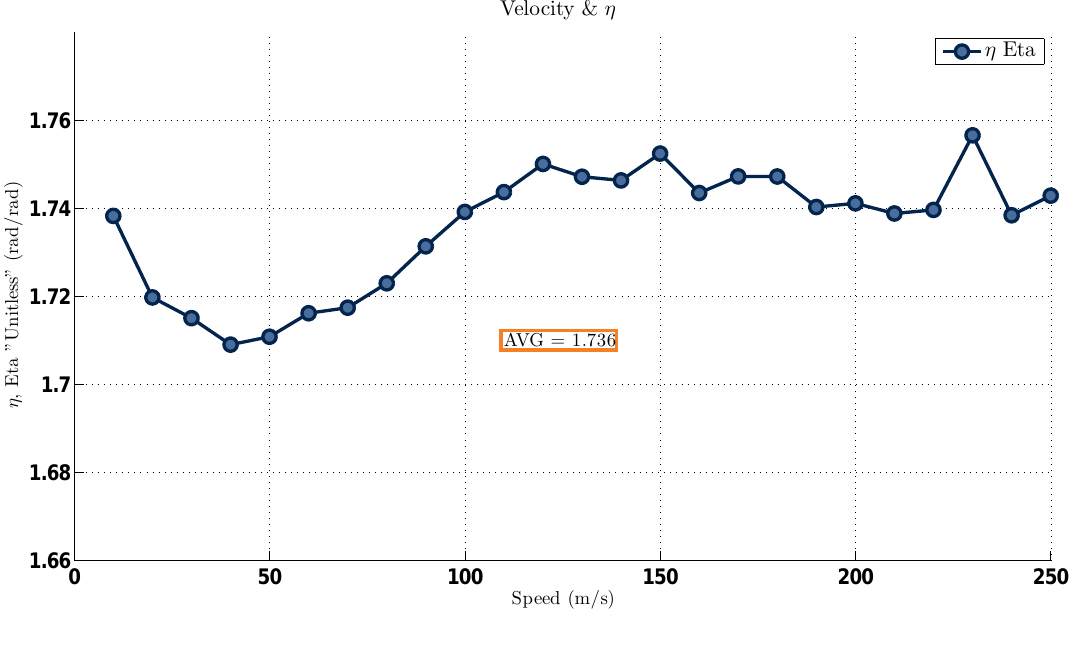
Figure 3. η values for DLC on a flat surface (10 km/h to 250